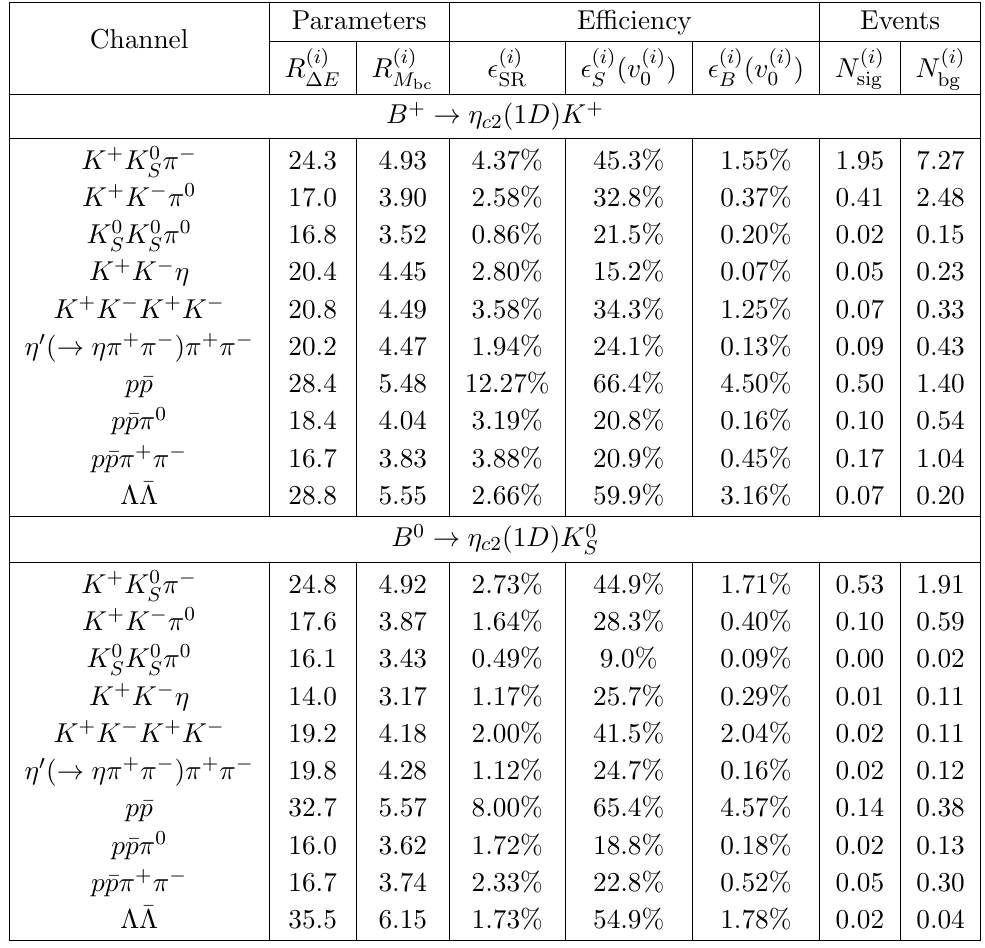
Table 3 . Results of the optimization of the selection requirements for the combination of the chan- nels B + . The expected number of signal events is calculated (cid:17) c 2 (1 D ) K + and B 0 (cid:17) c 2 (1 D ) K 0 S ! ! assuming ( B + ( (cid:17) (1 D ) 10 (cid:0) 5 and equal partial widths of the de- (cid:17) c 2 (1 D ) K + ) h c (cid:13) ) = 1 : 0 c 2 B ! (cid:2)B ! (cid:2) cays B + (cid:17) c 2 (1 D ) K + and B 0 (cid:17) c 2 (1 D ) K 0 . The e(cid:14)ciencies and expected numbers of signal and ! ! background events are calculated for the training sample. The signal-region half-axes R ( i ) are in MeV (MeV =c 2 ); all other values are